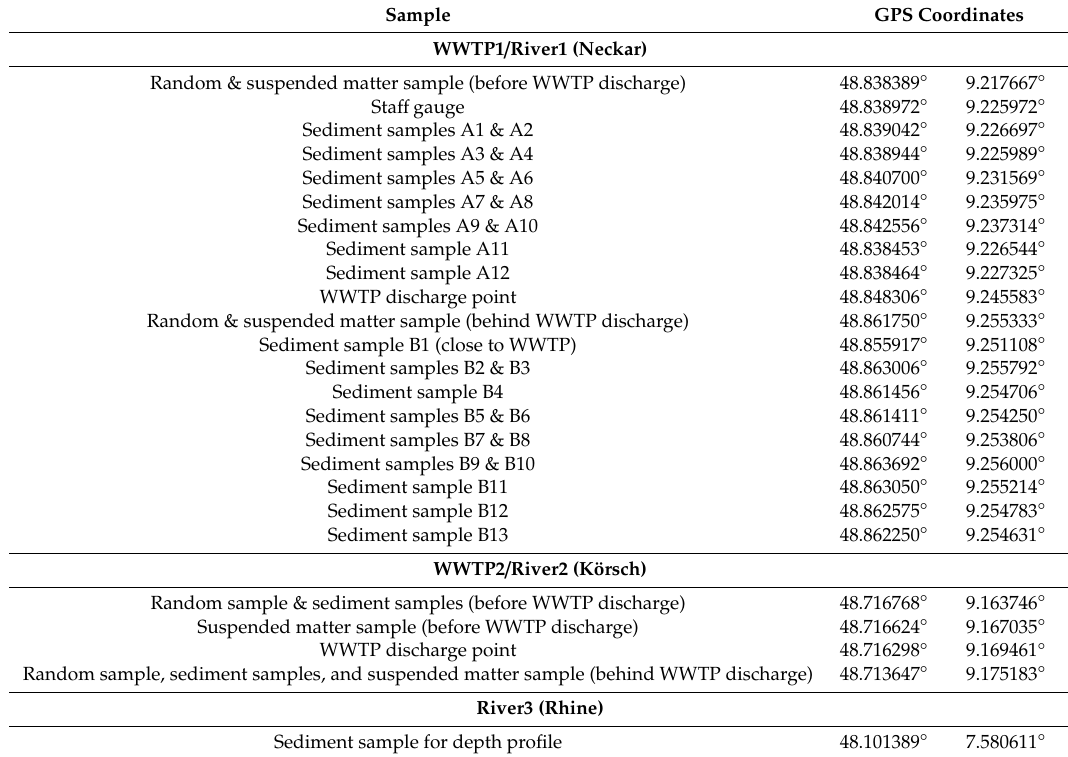
Table A1. GPS coordinates of all sampling points in River1, River2, and River3.